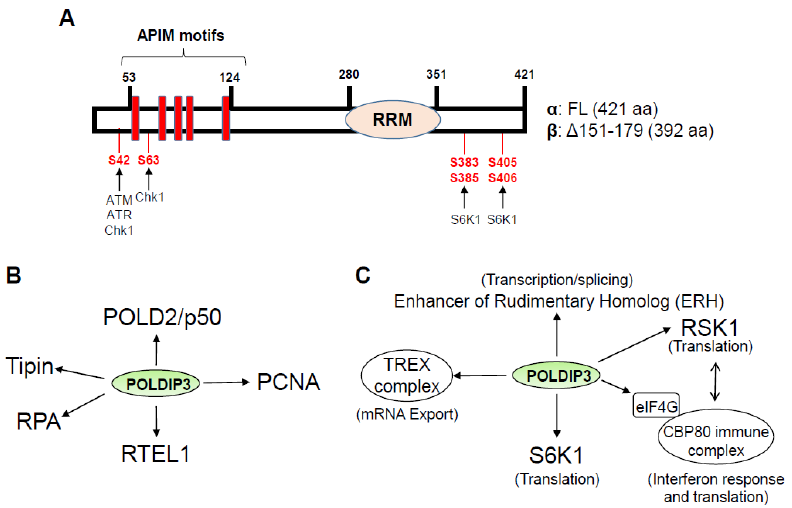
Figure 1. ( A ) Domain structure of human POLDIP3. The full-length POLDIP3 protein (POLDIP3-FL or POLDIP3 α ) contains 421 amino acids (aa). The β variant of POLDIP3 protein (POLDIP3 β ) contains 392 aa with residues between 151 and 179 deleted from the POLDIP3 α . The five APIM motifs, illustrated as five red rectangles, span from arginine-53 to lysine-124. The RRM domain spans from threonine-280 to asparagine-351. The serine residues and the potential kinases that phosphorylate them under different conditions are also highlighted. ( B ) POLDIP3 interactors that are implicated in DNA metabolism. ( C ) POLDIP3 interactors that are implicated in RNA metabolism.